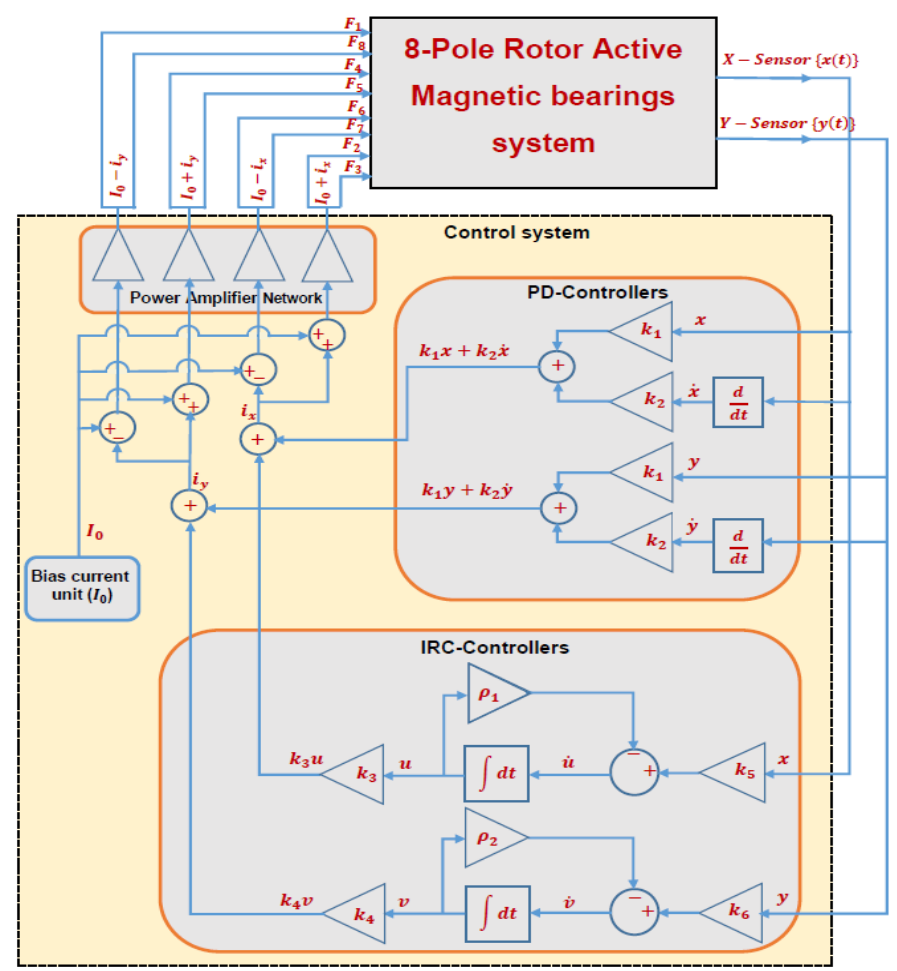
Figure 2. Block diagram to show the interconnection of both the proportional-derivative and the integral resonant controllers to the rotor system.